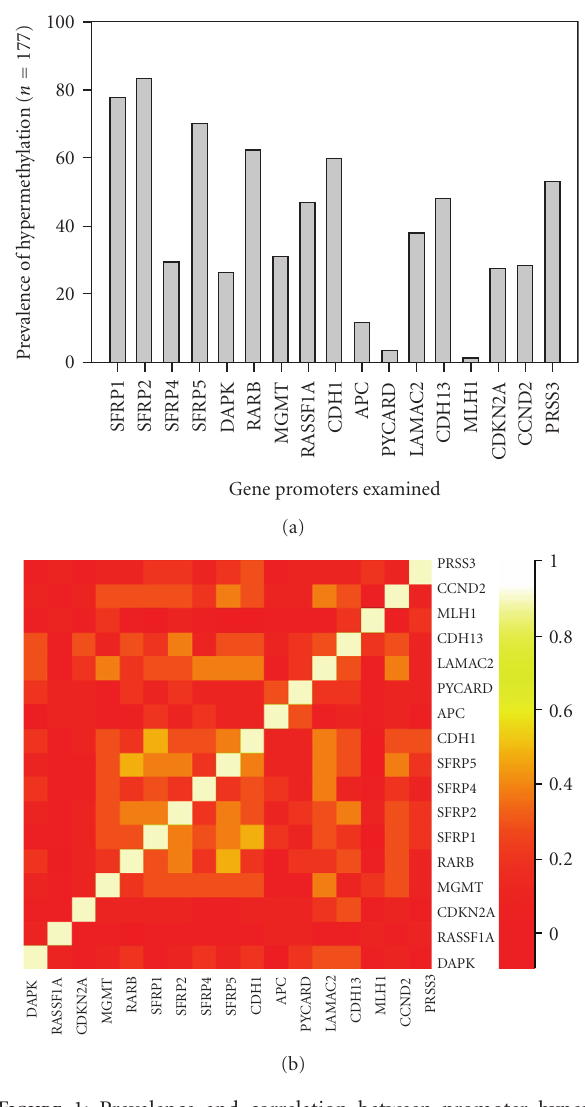
Figure 1: Prevalence and correlation between promoter hyper- methylation at 17 genes in NSCLC. (a) Bar graph representing the prevalence of promoter hypermethylation at various gene promoters examined in 177 NSCLC tumors. (b) Heat map depicting the correlation coe ffi cient (as depicted in the gradient bar) between individual promoter hypermethylation of 17 genes examined in